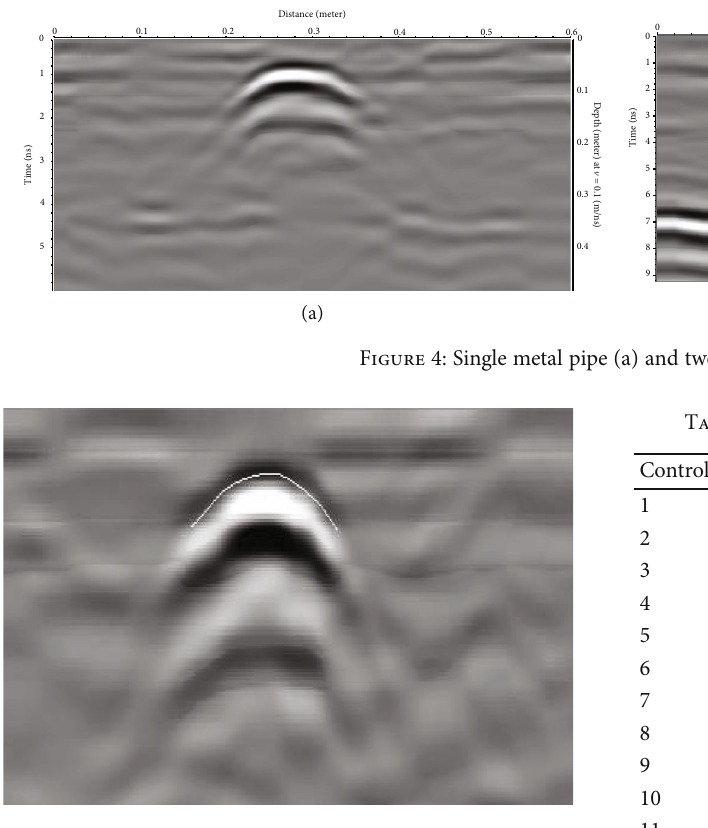
Figure 5: Spline curves with similar GPR patterns.